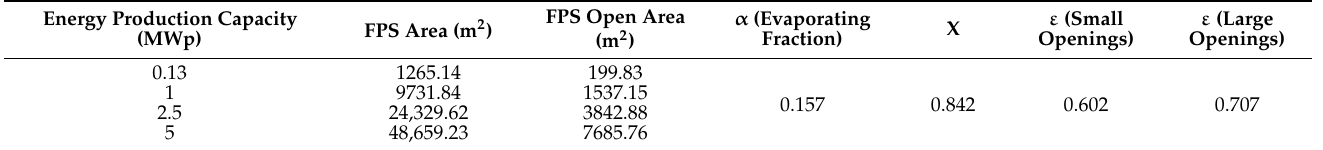
Table 4. Results of the evaporation reduction efficiency relation for the Floating Photovoltaic System.